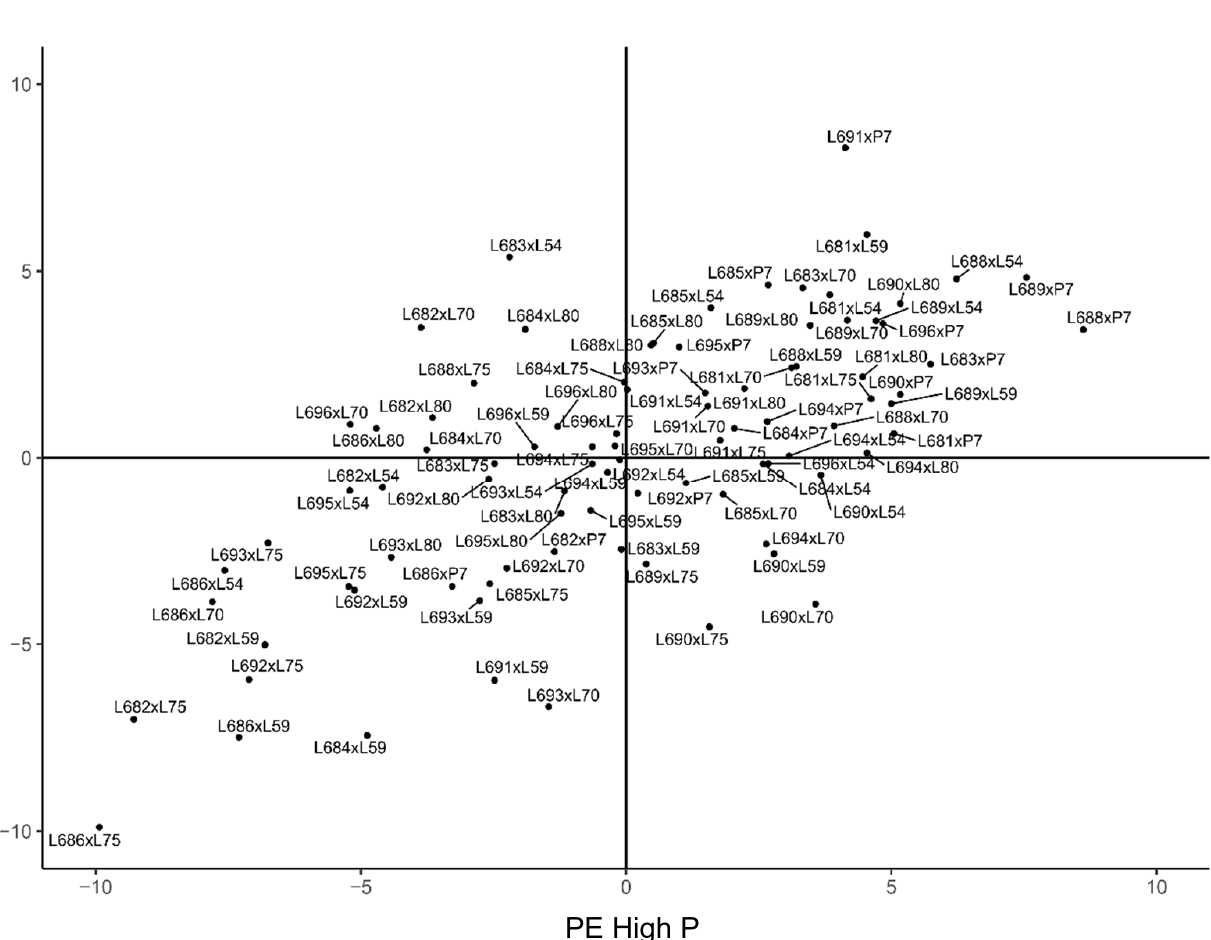
Figure 5. Estimates of the genotypic value ( 𝑠̂ ) for popping expansion (PE) in diallel hybrids of popcorn evaluated under high and low phosphorus availability in Campos dos Goytacazes. (-) signal indicating negative values.